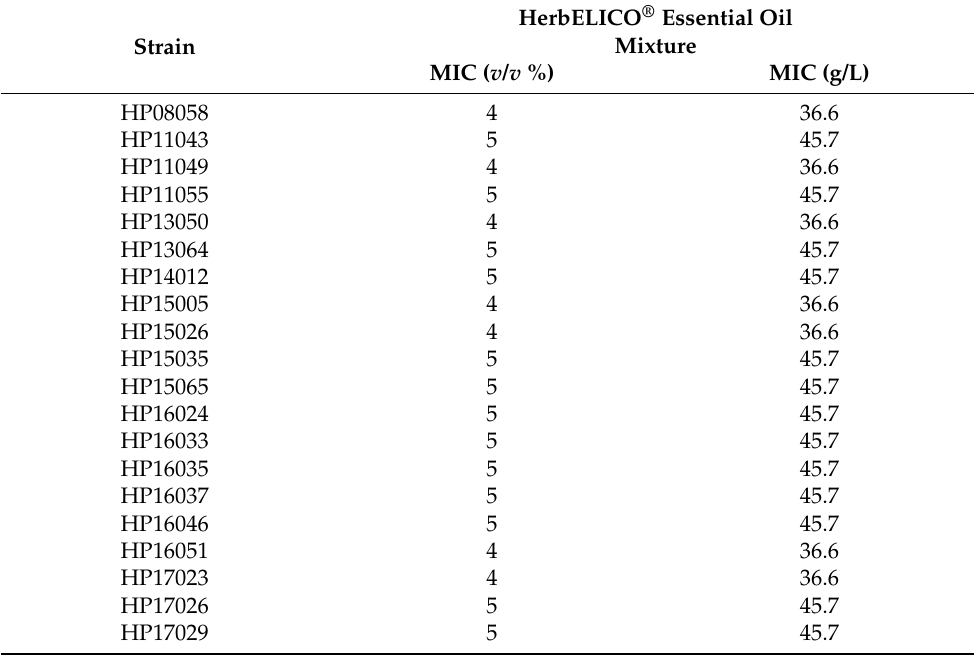
Table 3. The MIC values of HerbELICO ® essential oil mixture for H. pylori strains obtained by agar dilution